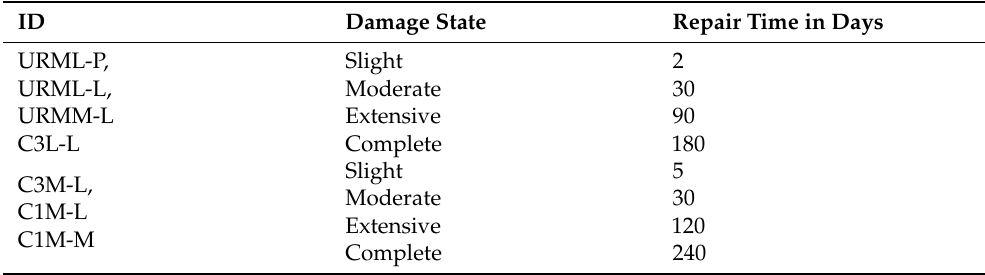
Table A5. Repair time estimation for different building types given damage state.